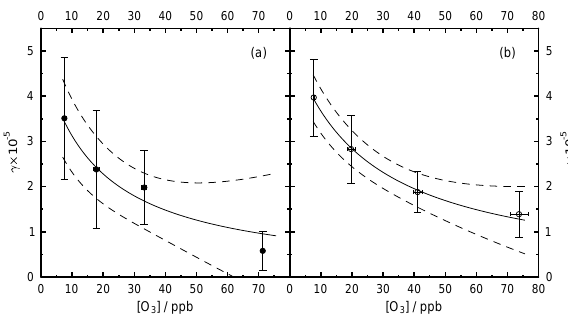
Fig. 8. Steady-state reactive uptake coefficients, γ , of 1:1 by mass PP/NG substrate with O 3 as a function of O 3 concentration un- der VIS (a) and UV (b) irradiation. Errors bars denote 1 σ of the mean γ . The solid lines represent a Langmuir–Hinshelwood reac- tive uptake mechanism fit to the data, and dashed lines indicate cor- responding 95% confidence